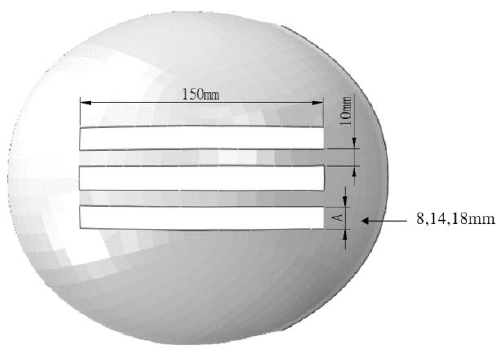
Figure 3. Prototype open-face helmet design with additional ventilation slots.